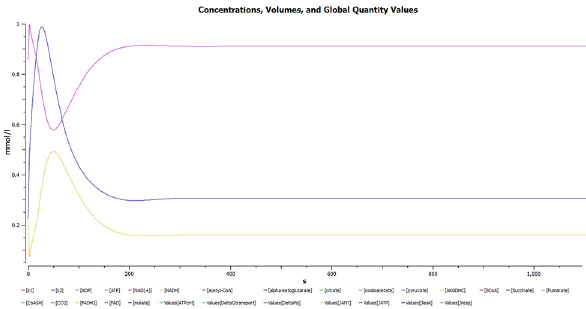
Fig 13. Glucose linked fluxes and Stoichiometric matrix. A. 7 reactions of glucose, in the human metabolome representing their fluxes. Glucose is produced in many of the reactions due to the reduction of the product being carried out enzymatically or by the presence of another energy currency NADH in RE85. B. Stoichiometric matrix generated using COPASI. Kinetics for multi-compartment reactions are assumed to already be expressed in units of amount of substance (e.g. moles) per time. The resulting value is then multiplied by a factor to convert amount of substance per time to particle numbers per time. Linear combinations of these values, using the stoichiometries as coefficients, result in particle number rates for all species. These form the right hand side of the differential equations.Technically finding the conservation relation means finding rows in the stoichiometry matrix that can be expressed as linear combinations of other